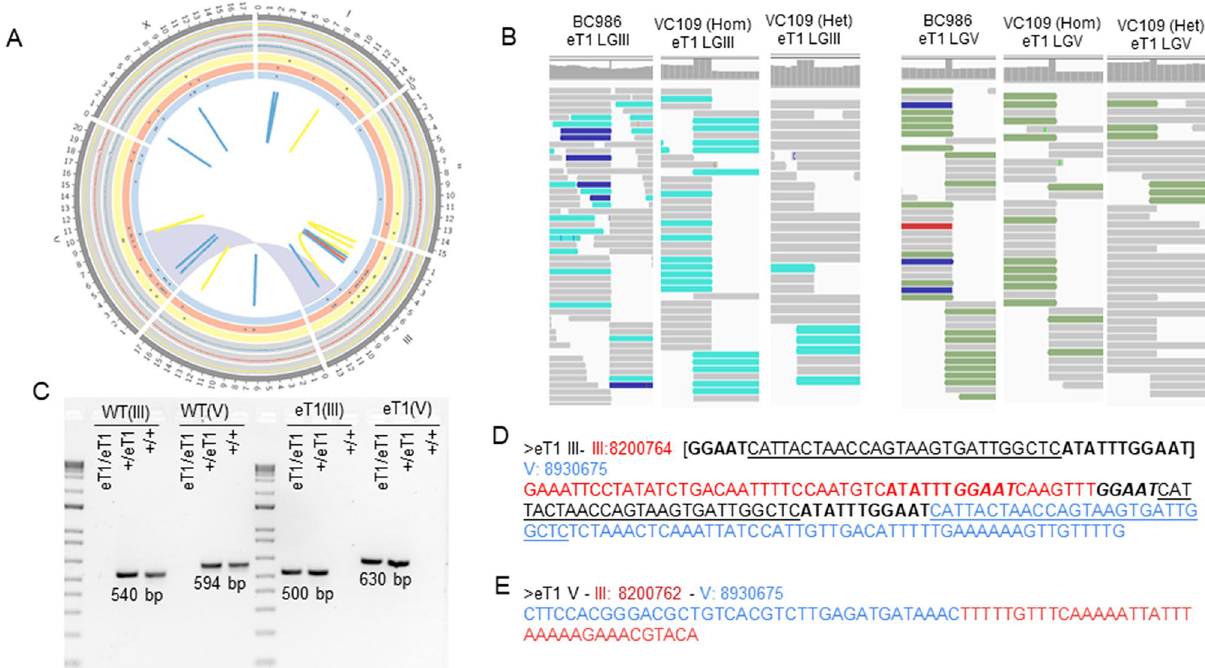
Figure 1. Overview of eT1 genomes and validation of eT1(III;V) reciprocal translocation breakpoints. ( A ) Circos plot created with Circos 62 with information regarding BC986 (yellow), wild-type looking VC109 (red; VC109 Het), and unc-36 VC109 (blue; VC109 Hom) genomes. The outer section is composed of three-line charts (one per strain) representing the ratio of coverage calculated by windows of 1 Kb and divided by the strain-specific genome coverage. The middle section is composed of three scatter plots. Each dot represents the genomic position of heterozygous SNPs identified in each strain. The inner section highlights, with links and ribbons, SVs and complex rearrangements identified in each strain. The eT1(III;V) reciprocal translocation is displayed by a blue ribbon. For better resolution, see Supplemental Fig. S1. ( B ) Signature of reads aligned around the eT1 breakpoints, visualized with IGV, BC986, wild-type looking VC109, and unc-36 VC109 genomes. ( C ) PCR agarose gels validating eT1 breakpoints and heterozygous and homozygous genotypes in VC109. ( D , E ) Sequences at eT1 junctions on LGIII ( D ) and LGV ( E ) resolved by Sanger Sequencing. The junction on LGIII shows microhomologies with flaking regions. The sequence in red is from LGIII, the sequence in blue is from LGV. The sequence in black is the de novo sequence inserted at the junction, composed of microhomologies of the surrounding sequences. We represented the microhomologies between the junction sequence and the surrounding sequences with bold, italic and underlined